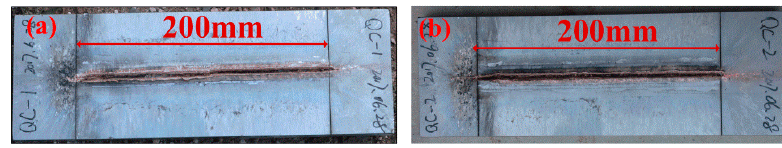
Figure 7. Experimental results of shaped charges: ( a ) LSC; ( b ) BLSC.